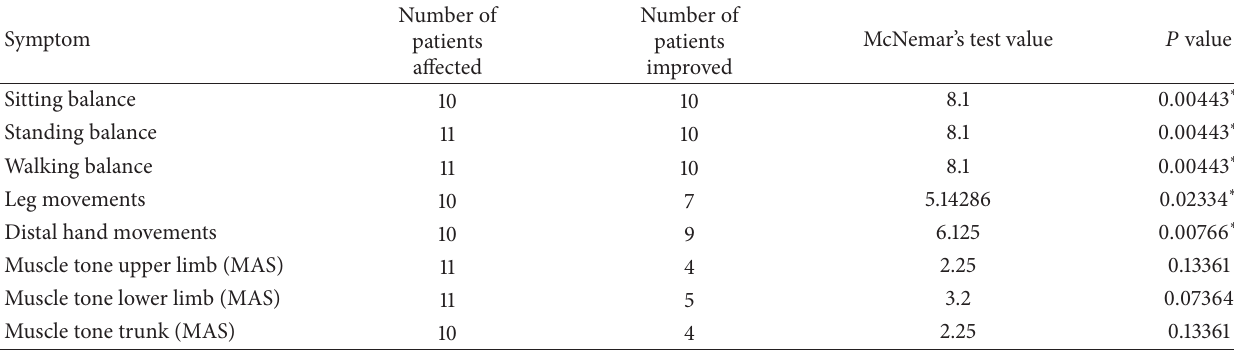
Table 4: Statistical analysis for each symptomatic improvement in diplegic CP using McNemar’s